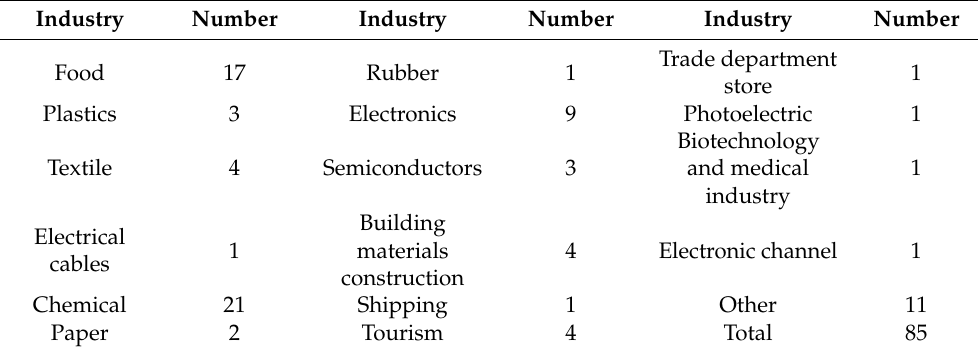
Table 1. Industry distribution of sample